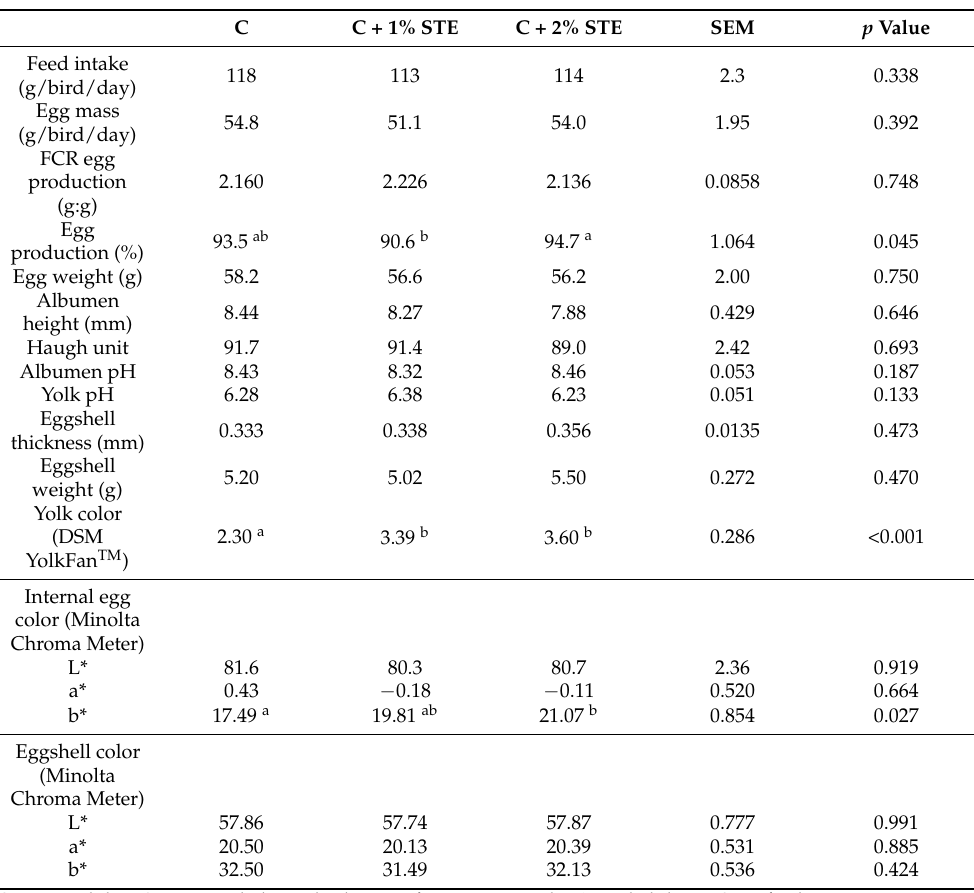
Table 3. Effect of dietary stevia (STE) on hen performance and egg quality variables at study endpoint. C C + 1% STE C + 2% STE SEM p Value Feed intake 118 (g/bird/day)